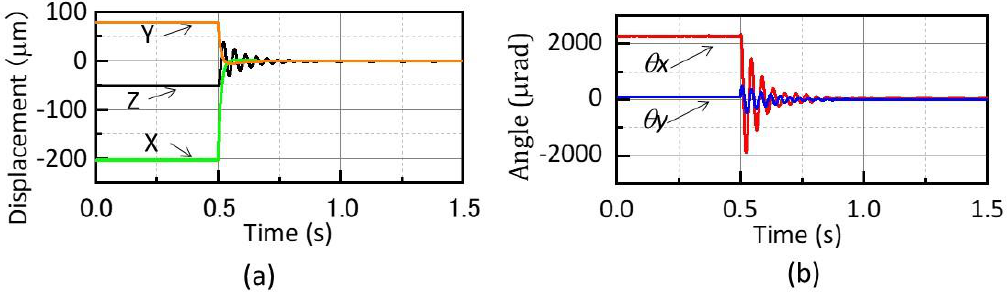
Figure 9. Startup response of the FSM using the magnetic suspension: ( a ) Translation in the X, Y, and Z directions; ( b ) inclination in the tip-tilt ( θx and θy ) directions.